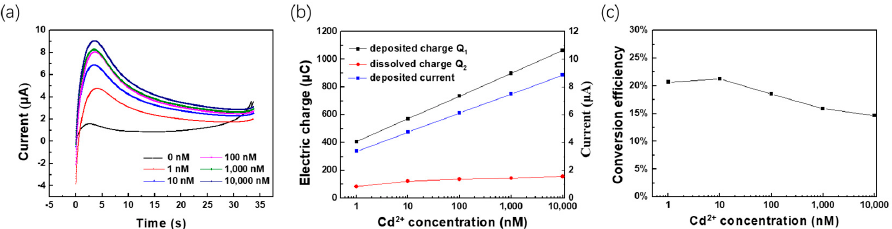
Figure 8. Analysis of the detection efficiency for Cd 2+ . ( a ) The relationship of dissolution current and scanning time; ( b ) The relationship of deposition current, deposition charge, dissolution charge and Cd 2+ concentration; ( c ) The relationship between Cd 2+ concentration and detection efficiency.